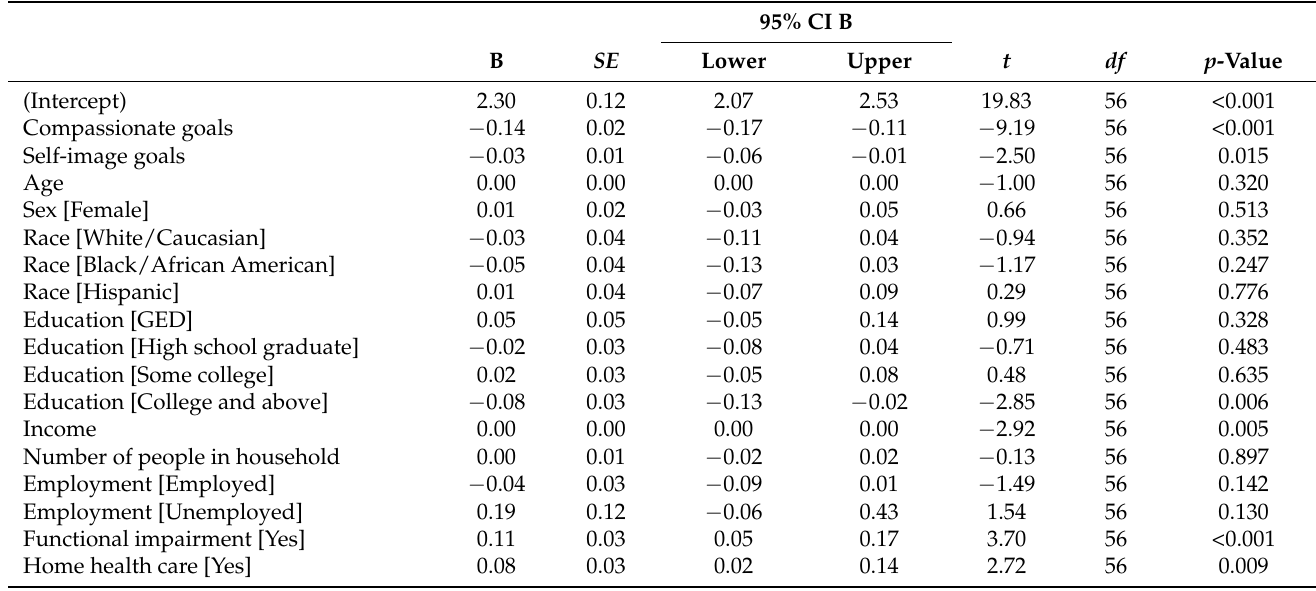
Table 4. Complex Samples General Linear Model Predicting Loneliness (Full Model).